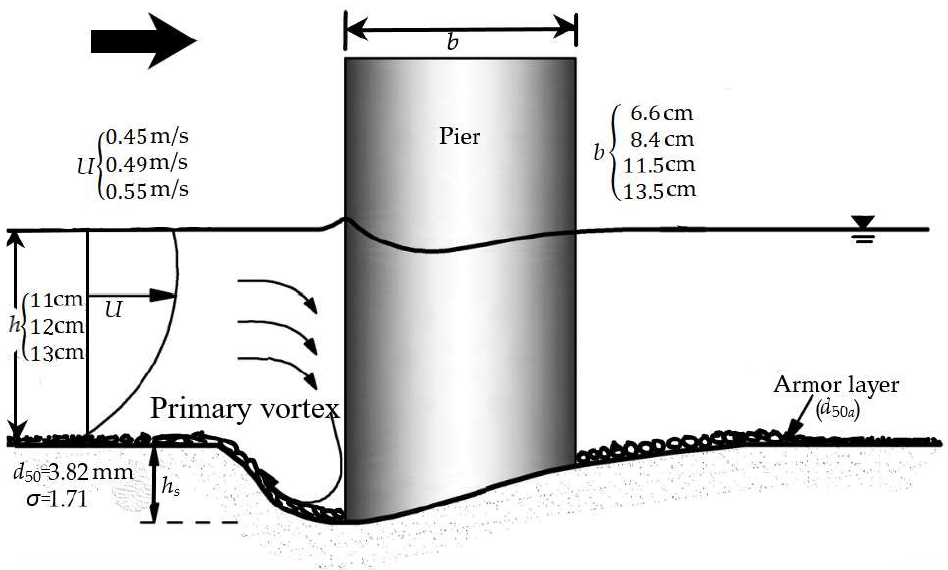
Figure 2. Scour around circular pier in armored streambed for case (b), refer to Table 1.